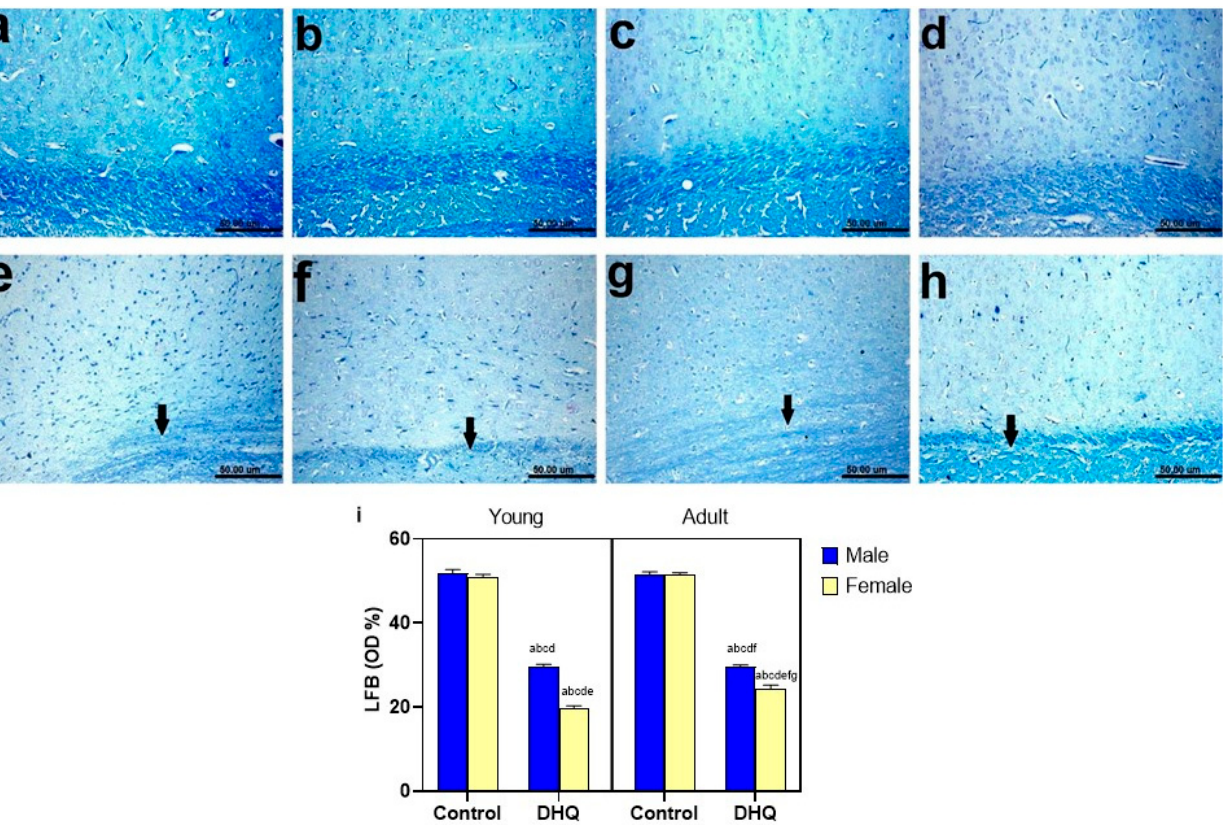
Figure 8. Histological Luxol fast blue-stained sections from cerebral cortex of ( a – d ) control rats, ( a ) young male, ( b ) young female, ( c ) adult male, and ( d ) adult female, showing apparently normal dark blue myelinated axons. ( e–h ) show demyelination (black arrow), ( e ) DHQ young male, ( f ) DHQ young female, ( g ) DHQ adult male, and ( h ) DHQ adult female. (Scale bar 50 um). ( i ) Quantitative analysis of LFB staining in cortical sections. Each bar with a vertical line represents the mean ± S.D. of 5 rats per group (5 fields/rat). a vs. control young male, b vs. control young female, c vs. control adult male, d vs. control adult female, e vs. DHQ young male, f vs. DHQ young female, and g vs. DHQ adult male using three-way ANOVA followed by Tukey’s post hoc test; p < 0.05. DHQ; diiodohydroxyquinoline.